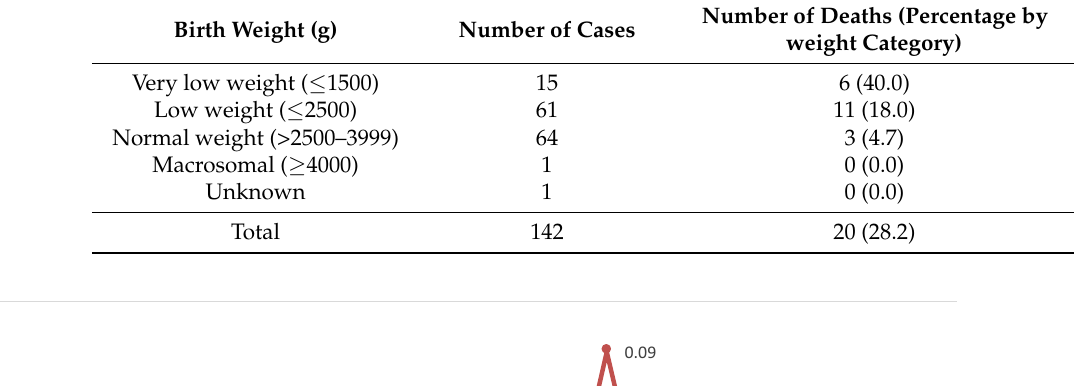
Table 2. Distribution of live-birth cases with oesophageal atresia, according to weight at the pregnancy ending and number of deaths at one year of life during the period 2007–2019 in the Valencian Region.